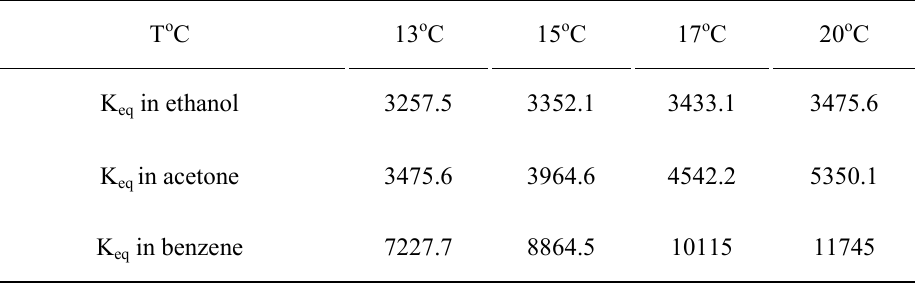
temperatures in acetone, ethanol and benzene.